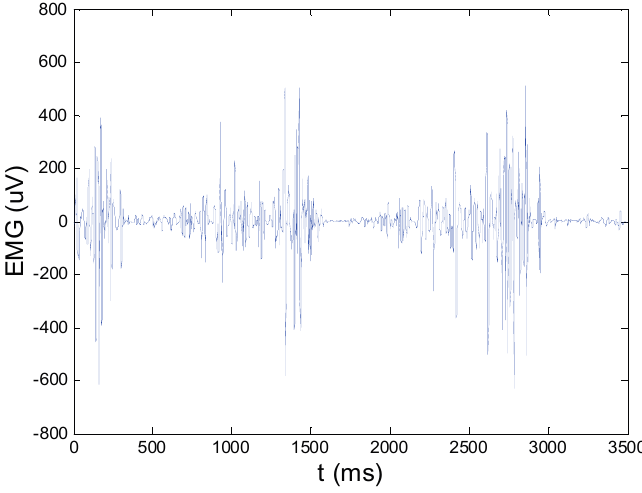
New Figure 15. EMG signal (shown in Figure 13) filtered by wavelet